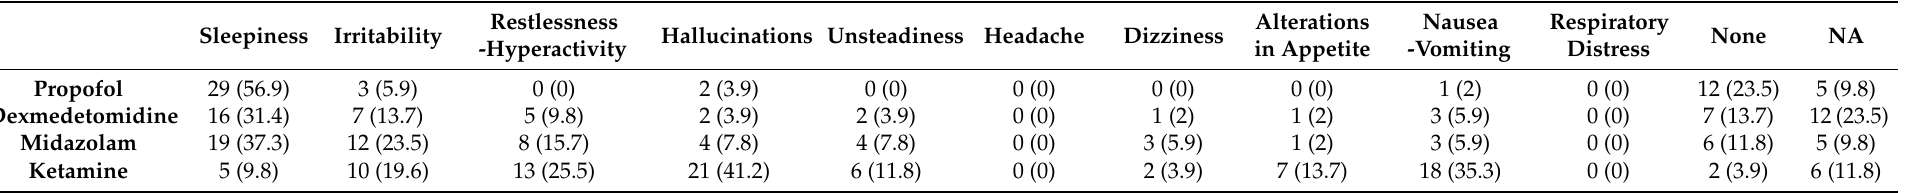
Table 2. Nurses’ opinion about the frequency of adverse effects experienced with four different pharmacological regimens ( n , %).